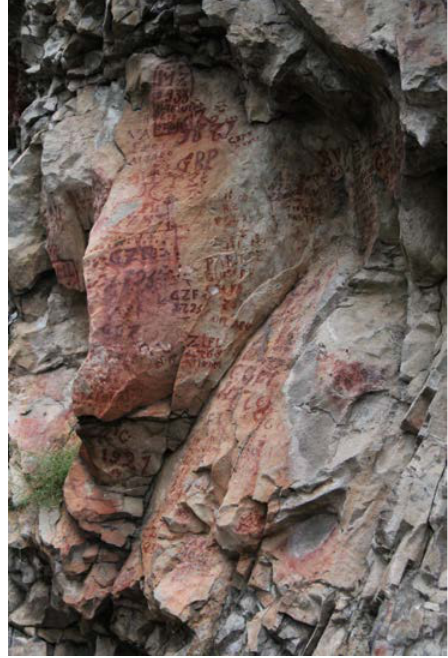
Figure 2 – Mount Cornón – Cava dal Bol LXIII. Courtesy of Museo degli Usi e Costumi della Gente